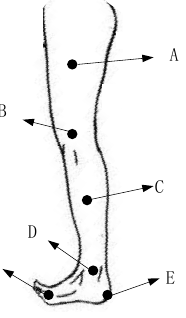
Figure 3. Location of the lower extremity collection mark ( A- thigh; B – knee; C – calf; D – ankle; E – heel; F - front foot. ). The gait acquisition interface is shown in Figure 4.